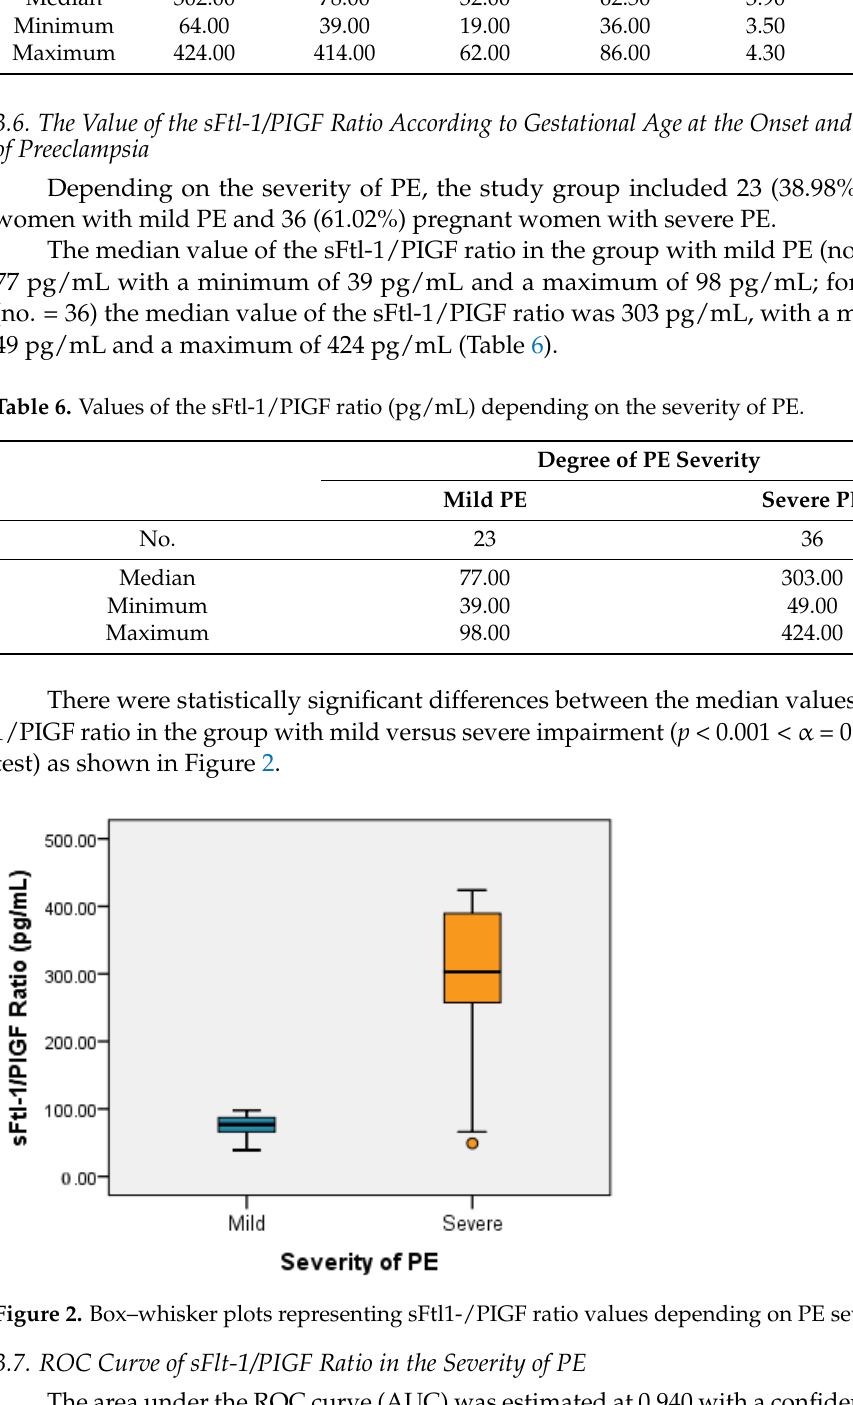
Table 5. Values of the sFtl-1/PIGF ratio depending on gestational age at onset. PE GH Control Early Late Onset Onset